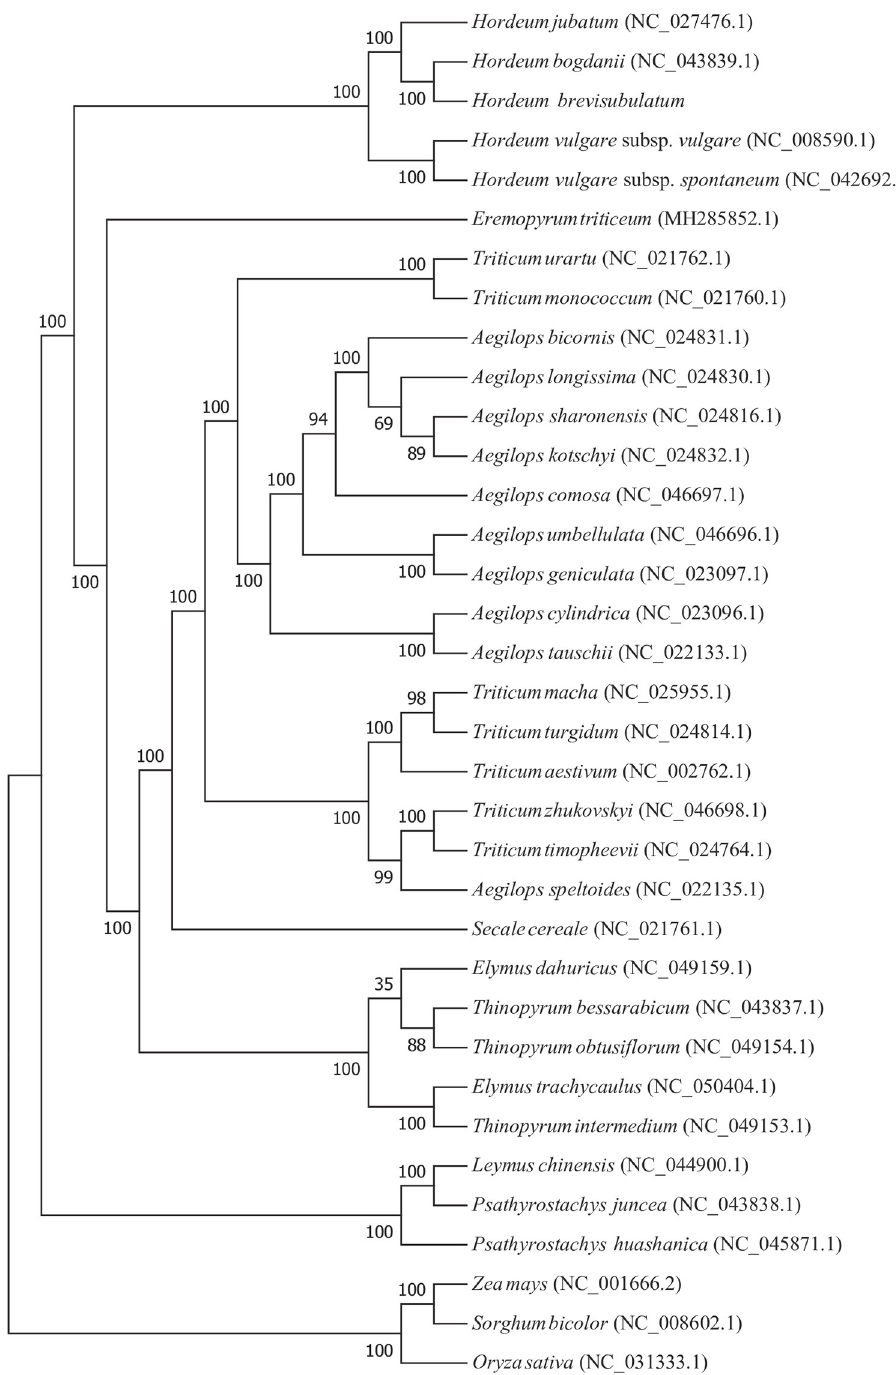
Fig 4. Phylogenetic relationships of 35 species based on complete cp genomes. The bootstrap values were based on 1000 replicates and are shown next to the branches. The cp genome accession numbers from GenBank are labeled near the names of plant